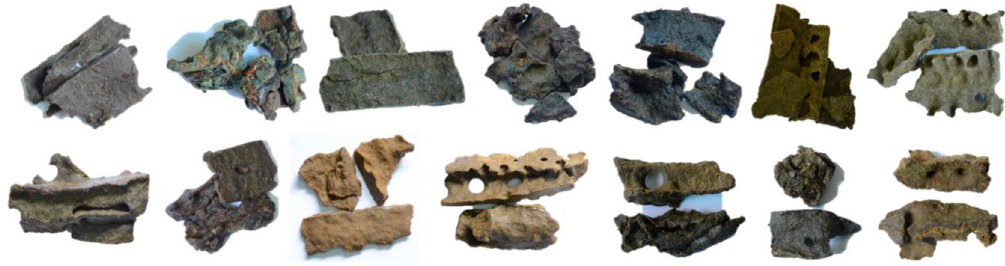
Figure 5. Fourteen Brazilian green propolis obtained from commercial suppliers.